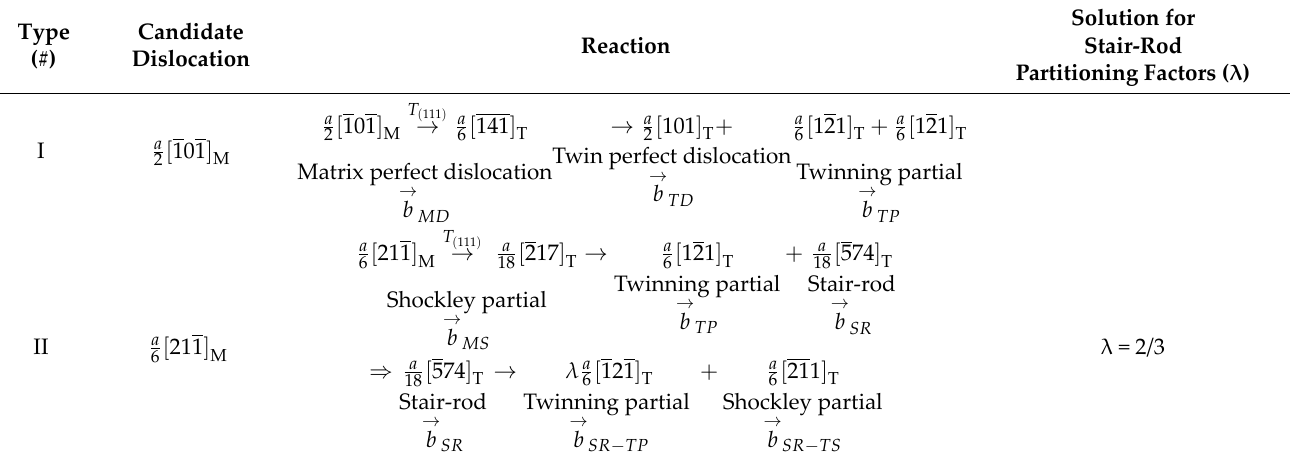
Table 4. Possible reactions between dislocation and twin boundary in this study; the unconventional → b SR ) and solution for stair‑rod partitioning factors ( λ ) of the FCC system stair‑rod Burgers vector ( is given. Reaction